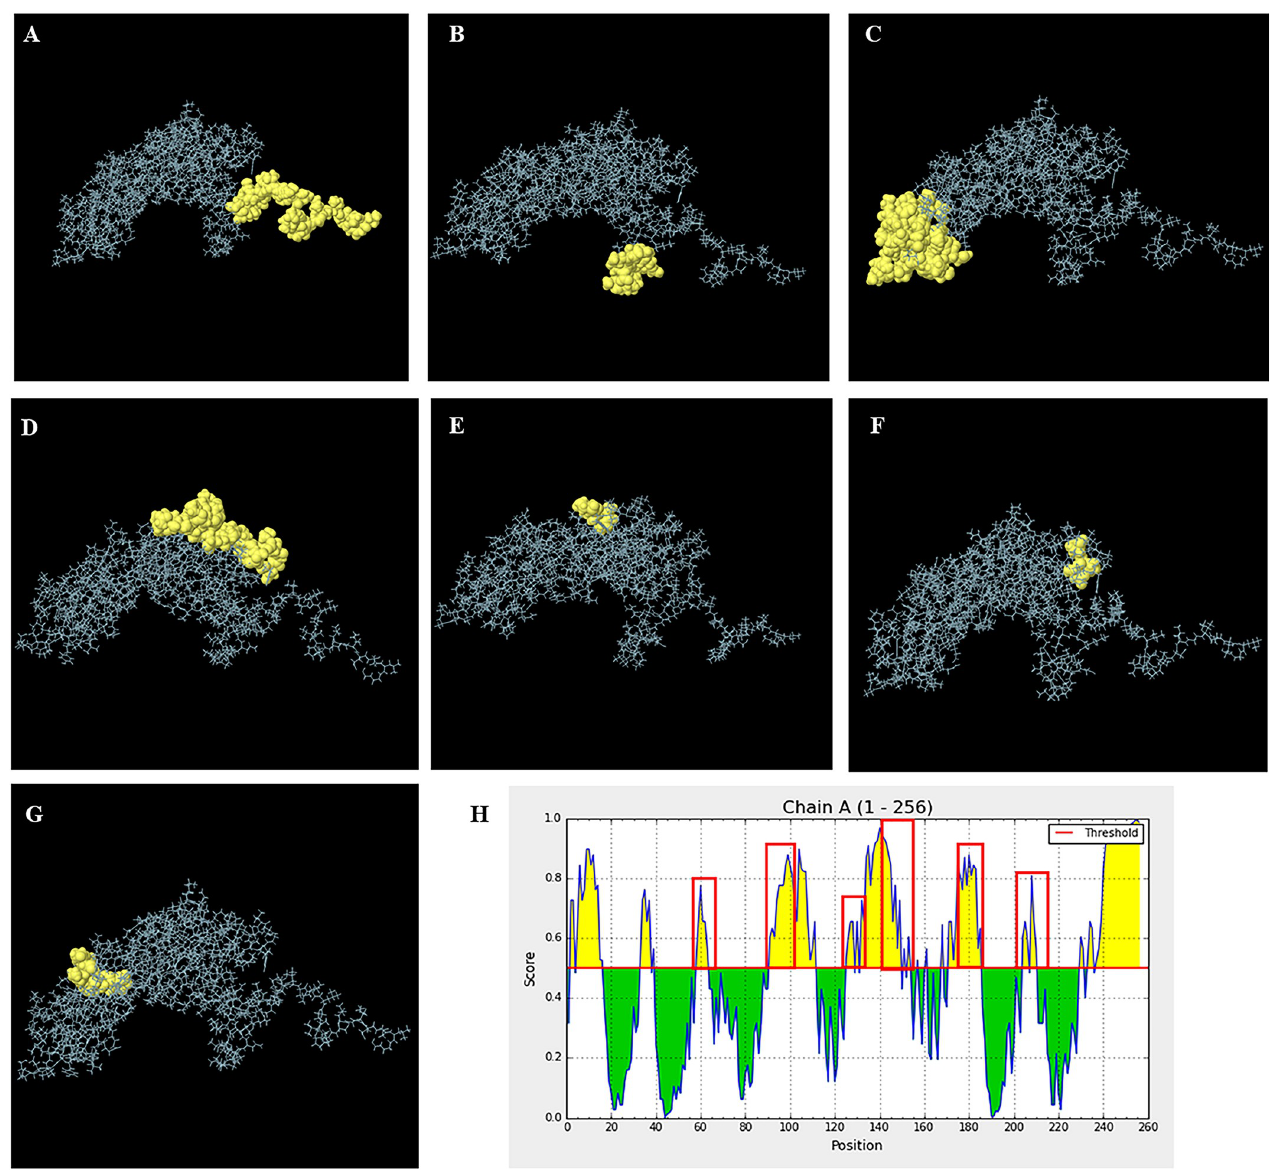
Fig 9. The presentation of B-cell epitopes of the 3D structure of the partial DnaK protein of CLE from R . annulatus predicted by Ellipro. (A-G) The predicted discontinuous B-cell epitopes of the 3D structure of the partial DnaK protein of CLE from R . annulatus . (H) The epitope prediction of B-cells based on the 3D structure of the partial DnaK protein of CLE from R . annulatus by the ElliPro server displaying the overlapping region in the same way as the linear structure prediction of IEDB-AR.